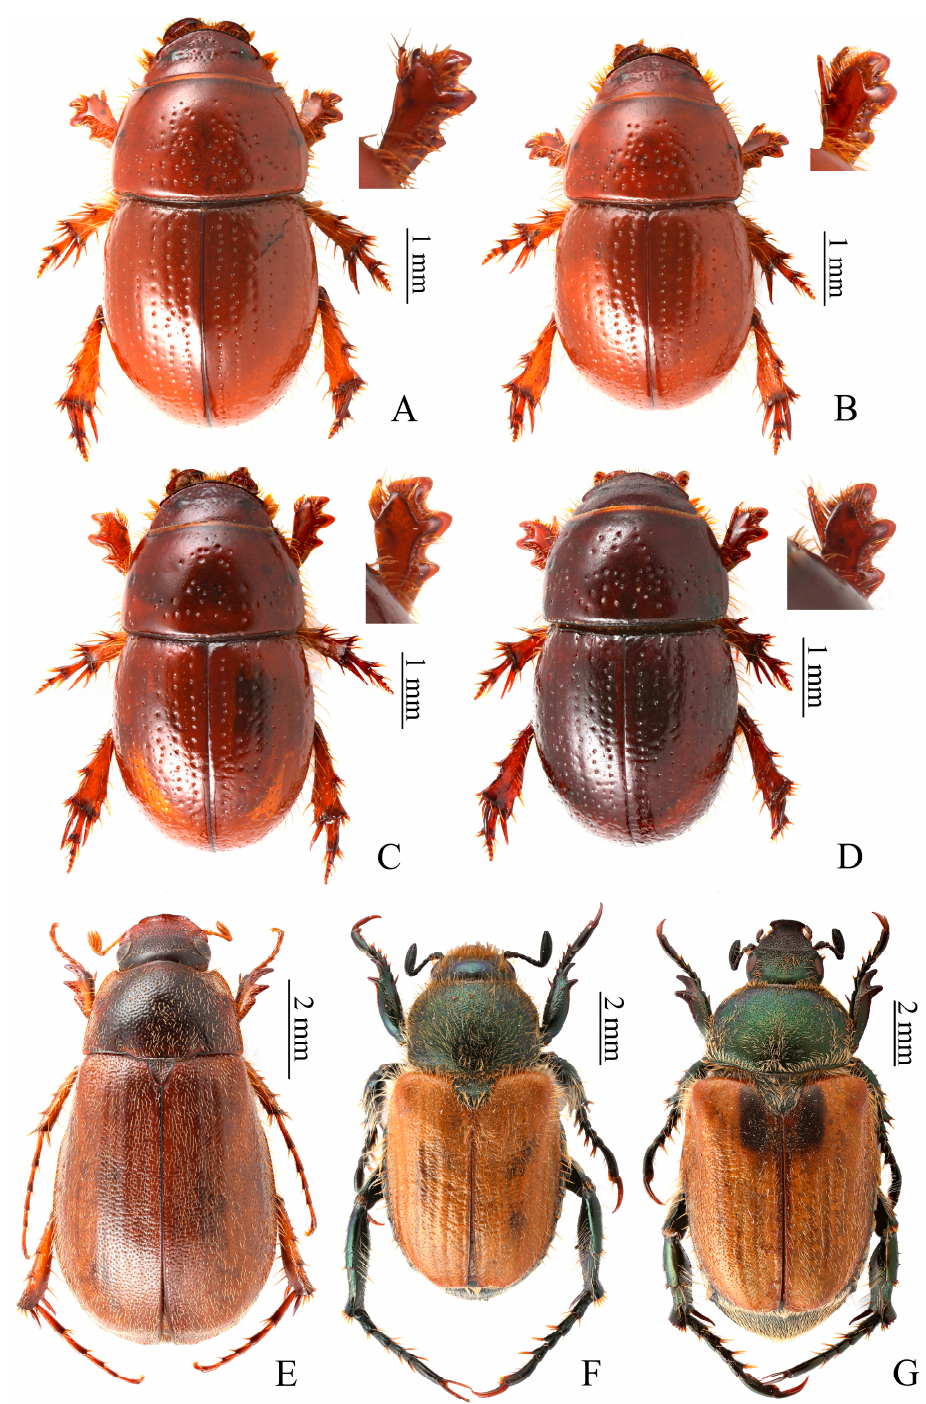
Figure 7. Rare and new species for the fauna of Serbia recorded in the course of this study: ( A , B )—Chaetonyx robustus robustus Schaum, 1862, ( C , D )—*Chaetonyx schatzmayri Mariani, 1946, ( E )—Triodontella dalmatica (Baraud, 1962), ( F , G )—Chaetopteroplia segetum straminea (Brull é , 1832) (Photos: Łukasz